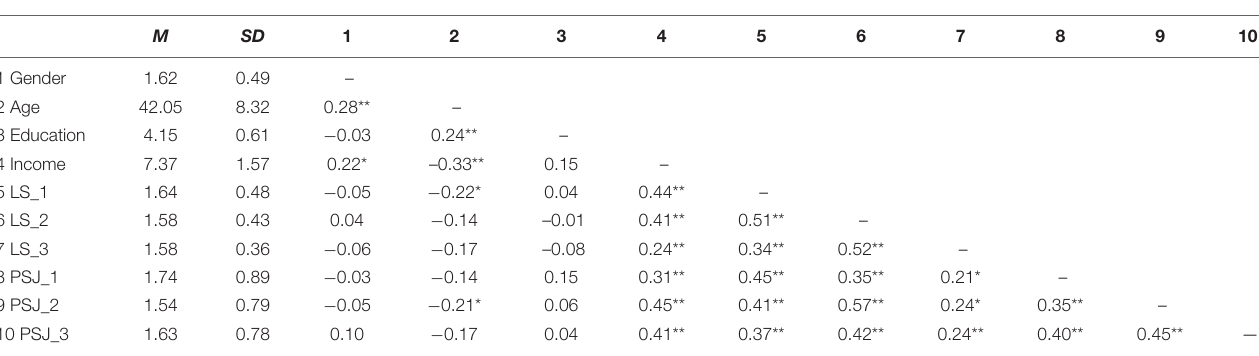
TABLE 1 | Means, standard deviations, and correlations in study